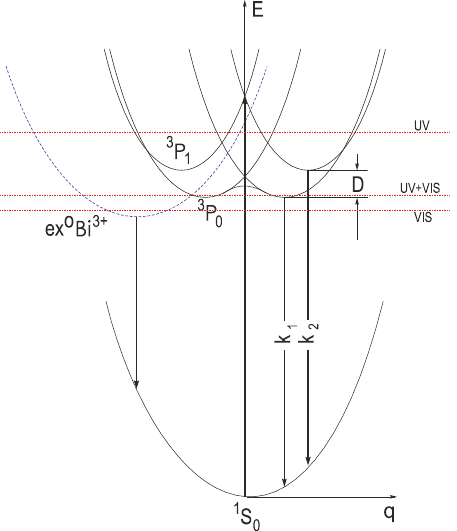
Figure 7. Schematic configuration coordinate diagram of the Bi 3+ -related energy levels. The electronic transitions between the ground state, corresponding to the 1 S 0 level, and the excited states, corresponding to the 3 P 1 and 3 P 0 levels of a free Bi 3+ ion and the triplet Bi 3+ -related localized exciton state (ex 0 Bi 3+ ), are indicated by arrows. The straight red dotted lines indicate the position of the bottom of CB in the case where only the UV emission (UV), only the VIS emission (VIS), and both the UV and VIS emissions (UV+VIS) can appear in the luminescence spectrum of a Bi 3+ -doped compound.